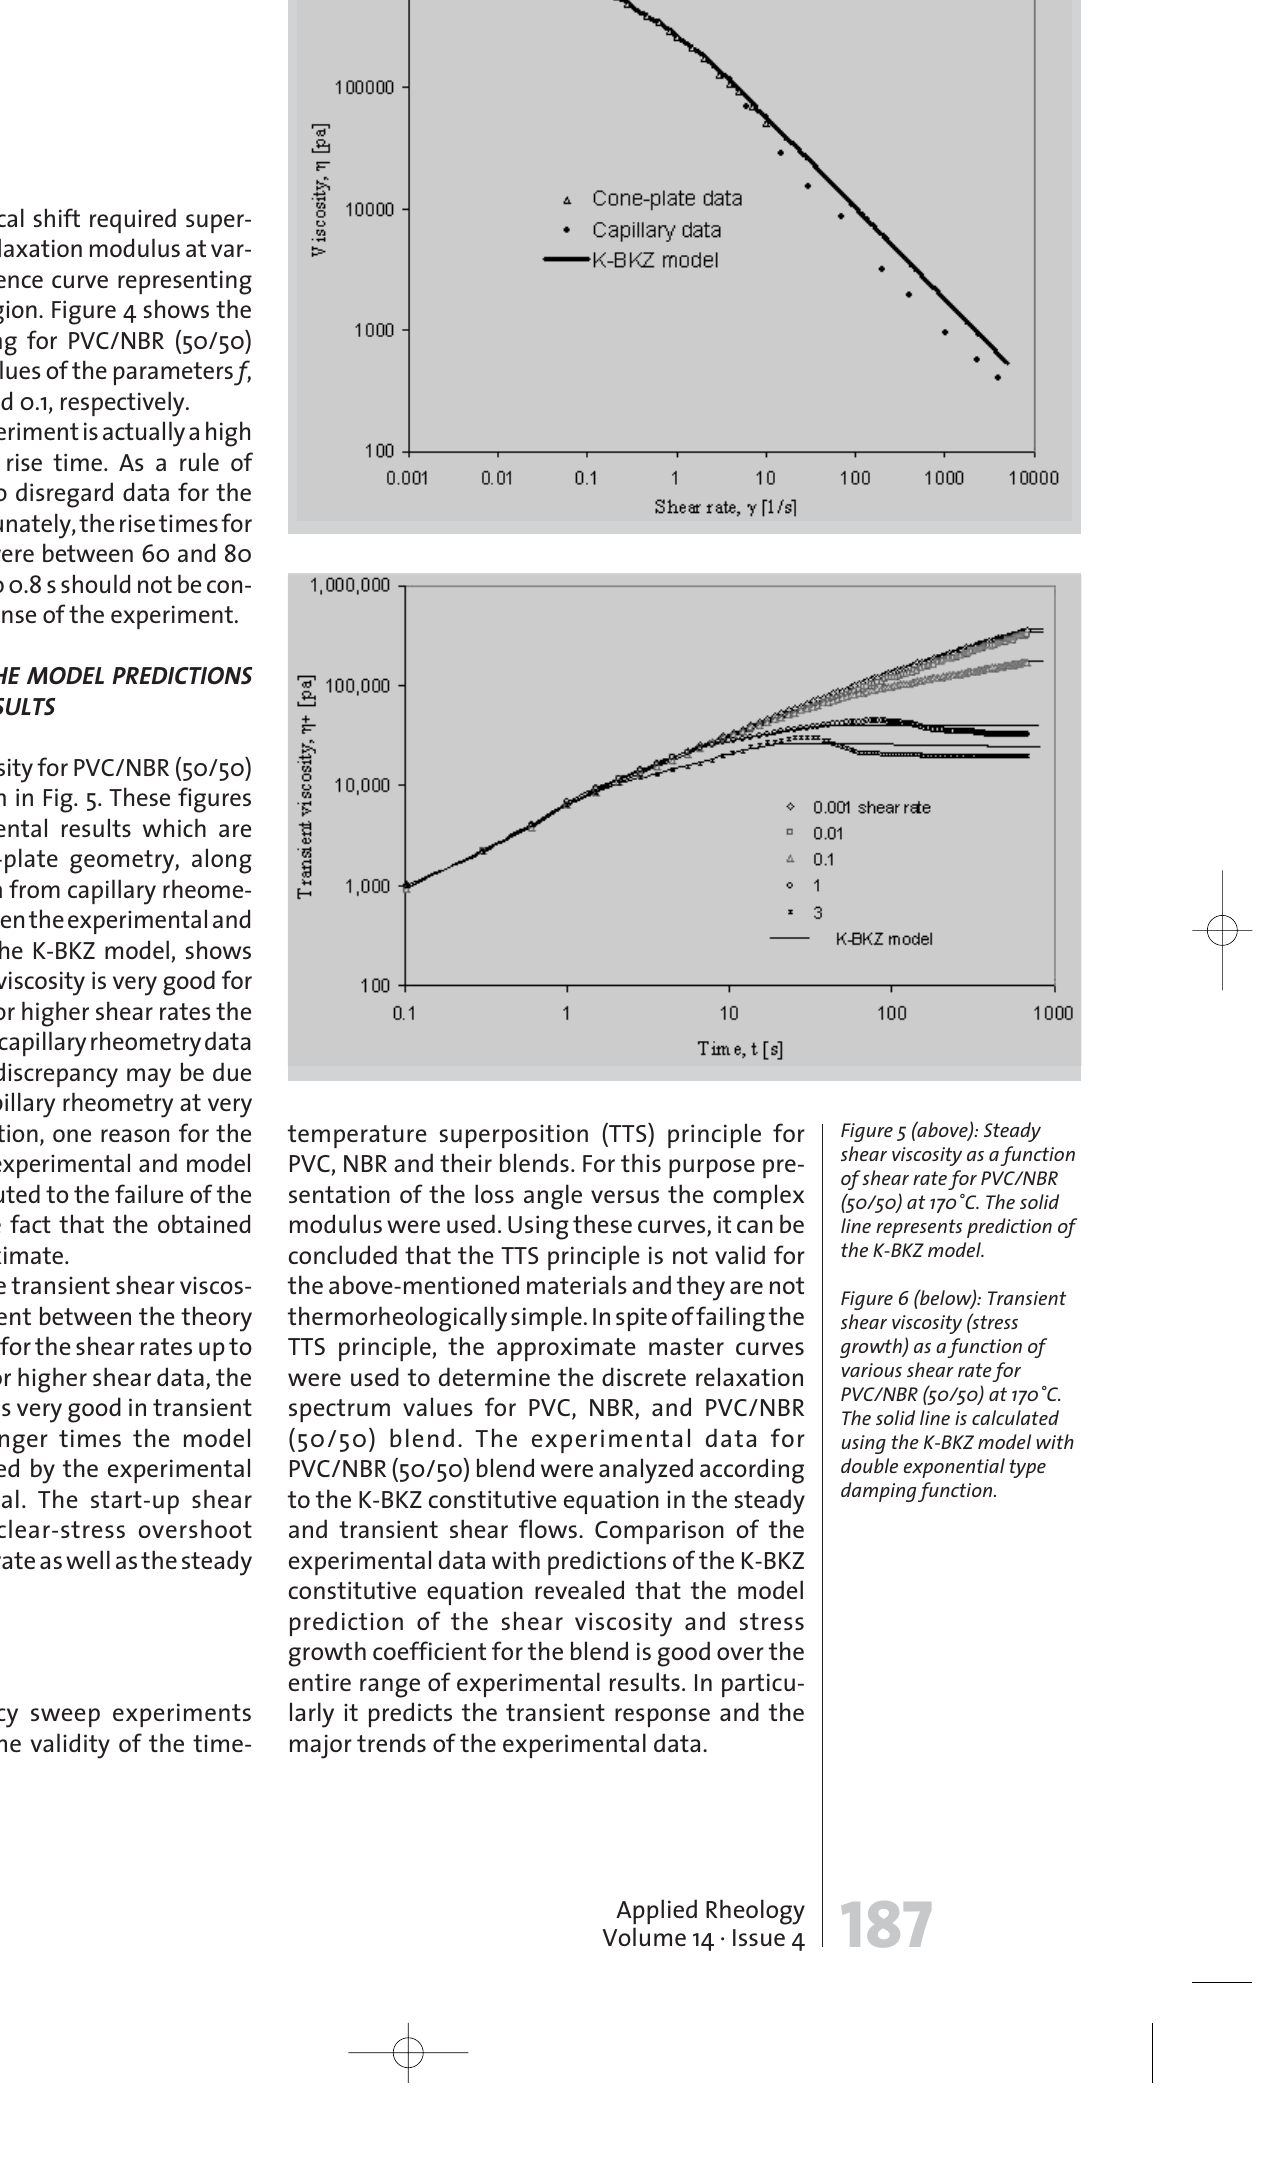
Figure 5 (above): Steady shear viscosity as a function of shear rate for PVC/NBR (50/50) at 170˚C. The solid line represents prediction of the K-BKZ model. Figure 6 (below): Transient shear viscosity (stress growth) as a function of various shear rate for PVC/NBR (50/50) at 170˚C. The solid line is calculated using the K-BKZ model with double exponential type damping